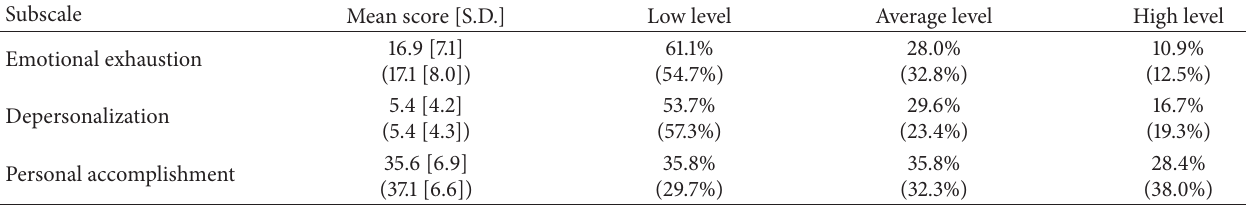
Table 1: Mean scores and categorization of burnout according to the MBI-HSS subscales among nursing managers (medical managers).